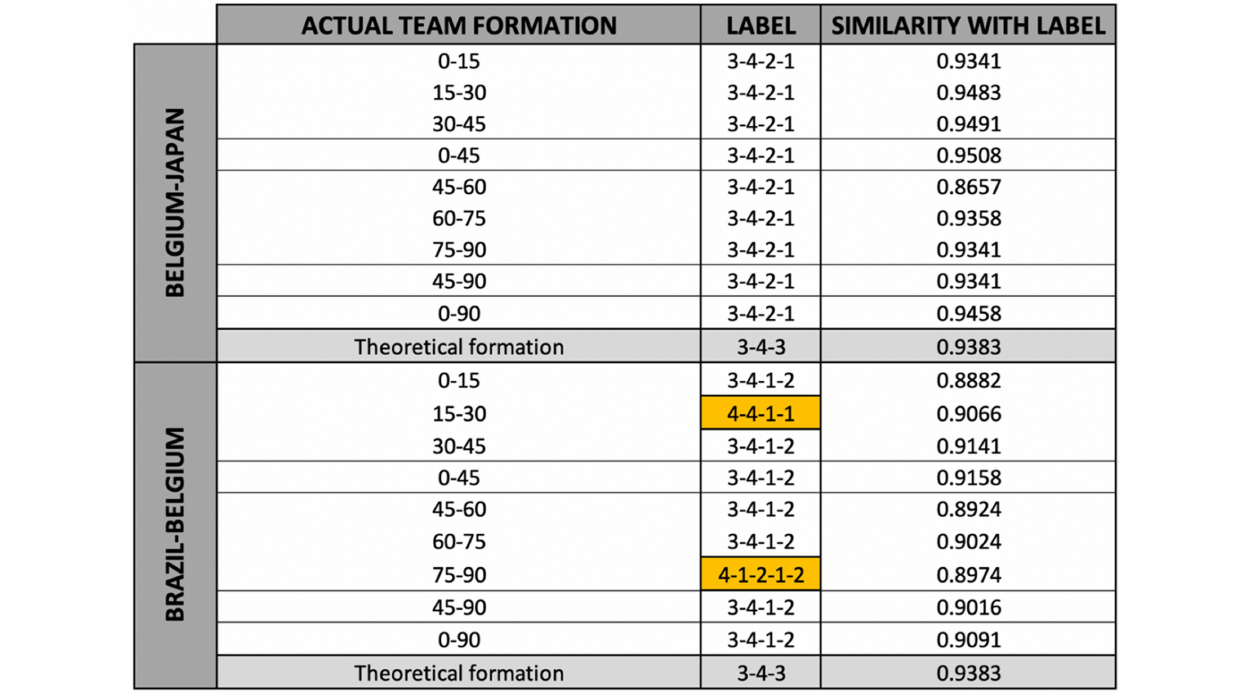
FIGURE 4 | Results of the experiment showing the reference team formation with the highest similarity for each of the actual performed team formations of the Belgian national football team during two matches of the 2018 FIFA World